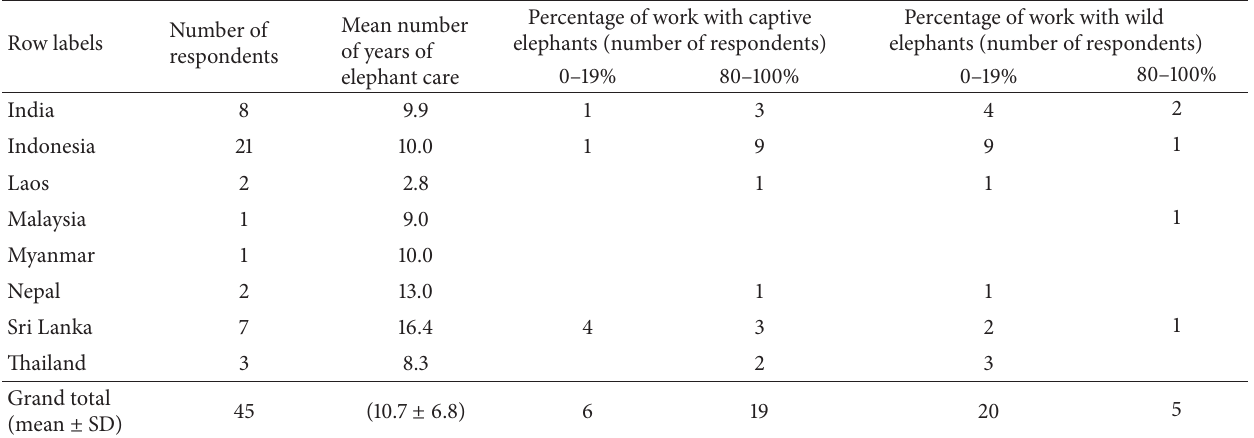
Table 2: Characteristics of elephant health survey